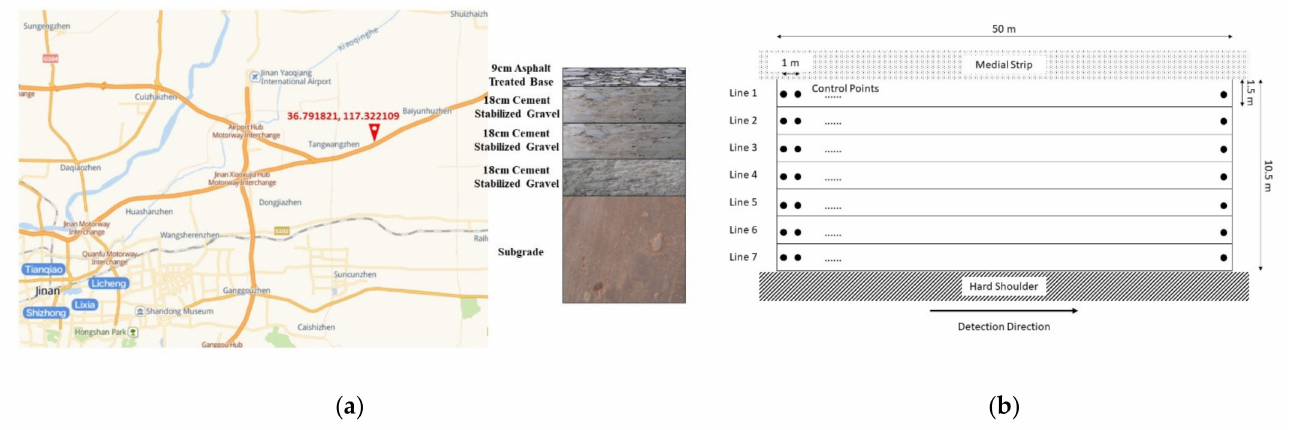
Figure 5. Location and pavement structure of the field test. ( a ) Location and structure; ( b ) Test